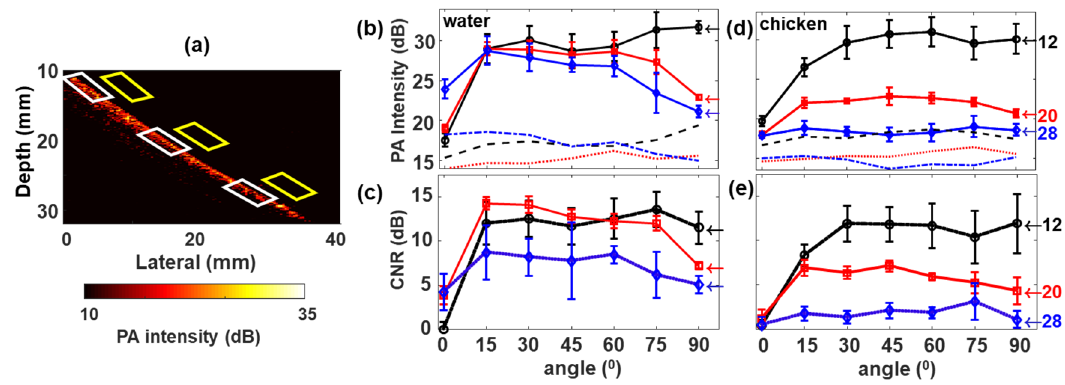
Figure 6. ( a ) PA image of a sample containing absorbing lesion (2 mm diameter) with the top water layer. White parallelograms indicate the regions selected for PA intensity and yellow for the background; ( b , d ) PA signal intensity plotted as a function of LED angles for selected depths in mm as labeled by numbers with the corresponding color, right next to each plot. Black circle with line corresponds to 12 mm, red squares with line corresponds to 20 mm and blue diamond with line indicates 28 mm. The black dotted lines, red dash-dotted lines, and blue dashed lines represent the background levels for 12, 20, and 28 mm depths (from the transducer) respectively; a gap of 10.5 mm exists between the transducer and the phantom surface. ( c ) CNR of the lesion under water; ( e ) CNR of the lesion under chicken breast. The error bars represent the standard deviation.